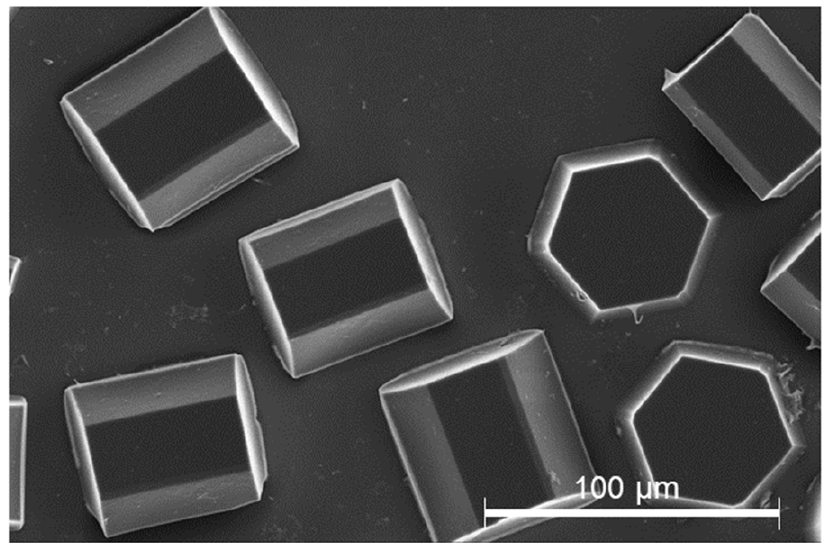
Figure 1. Cross-linked hexagonal HheG wild-type Figure 1. Cross ‐ linked hexagonal HheG wild ‐ type crystals.